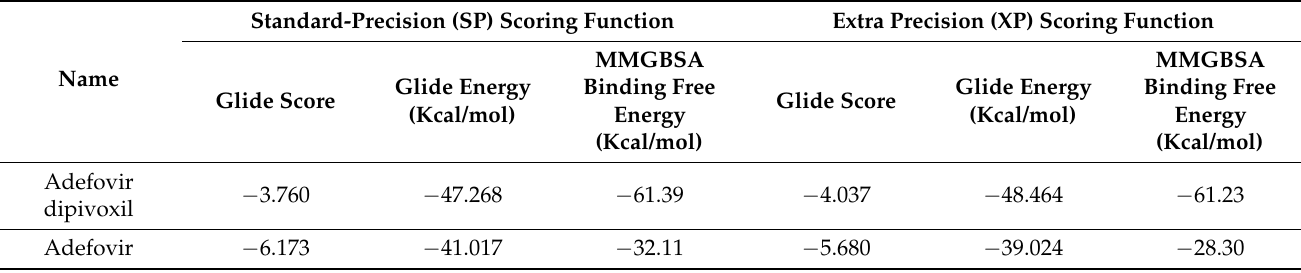
Table 1. SP and XP docking scores and MMGBSA binding free energy calculations of adefovir dipivoxil and adefovir against STAT3 SH2